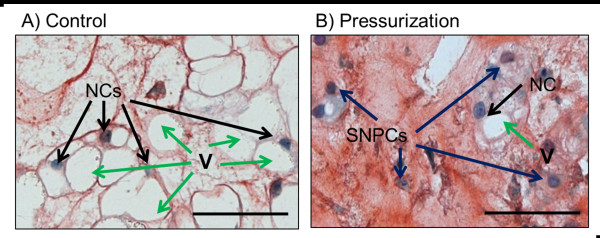
Quantification of large notochordal cells versus small nucleus pulposus cells. The number of notochordal cells (NCs) and small nucleus pulposus cells (SNPCs) in a total of nine images (3 images×3 spines used = 9) from each group (Control, 1 Dose and Daily) were counted and the percentage of NCs and percentage of SNPCs were calculated from the total number of cells in each image. (A) Control group image. (B) Pressurization group image. Black arrows, NCs; blue arrows, SNPCs. A large NC was defined as nuclei in direct contact and surrounded by large vacuoles, and an SNPC was defined as nuclei surrounded by matrix with no contact with vacuoles. V, vacuoles (green arrows). Scale bar = 50 μm.